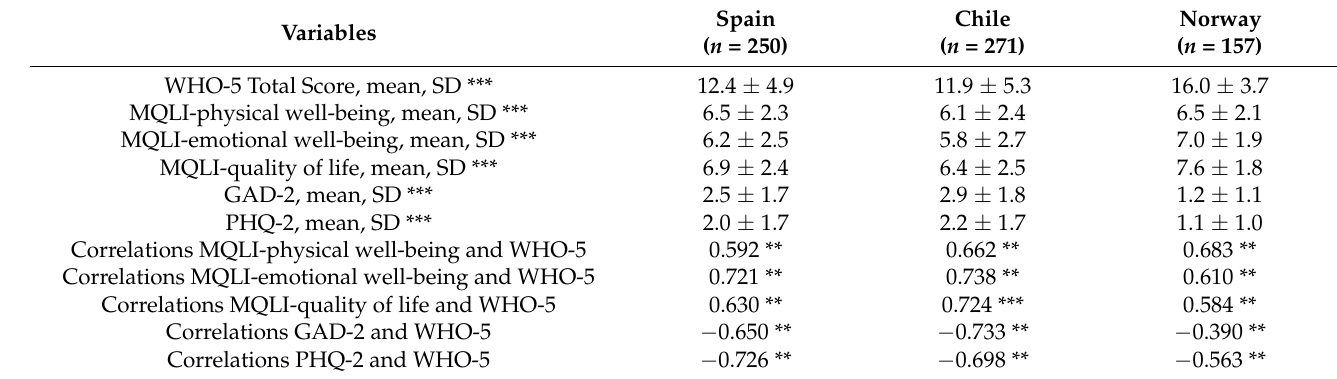
Table 1. Means (M), standard deviation (SD, ± ) and bivariate correlations of the study variables.